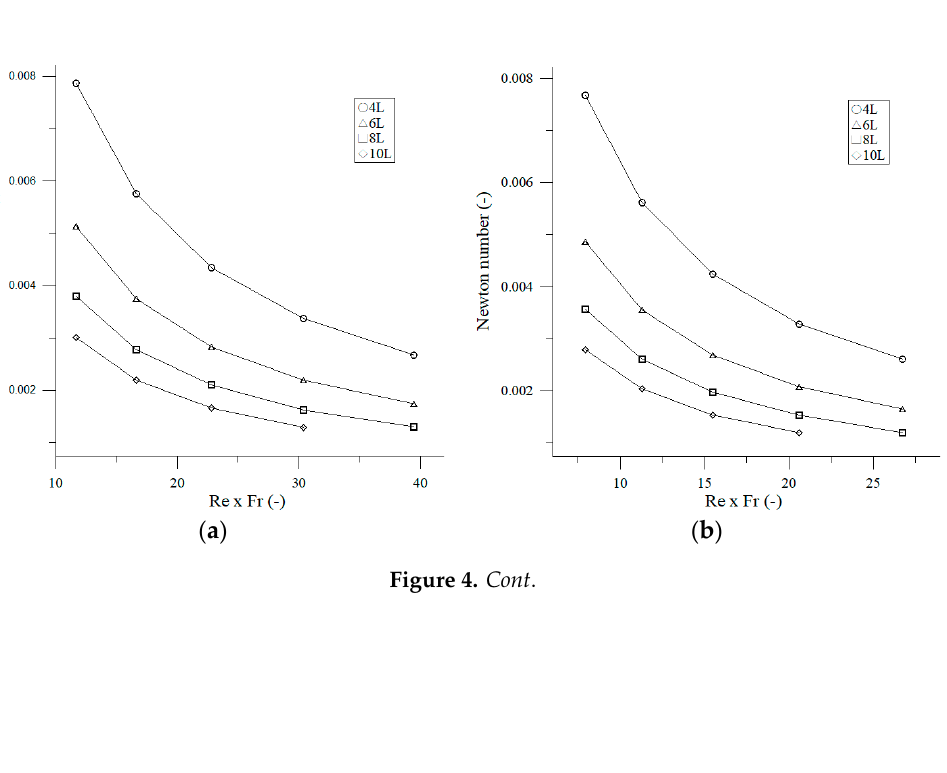
Figure 3. Relationship between Newton number and Reynolds number of different filling